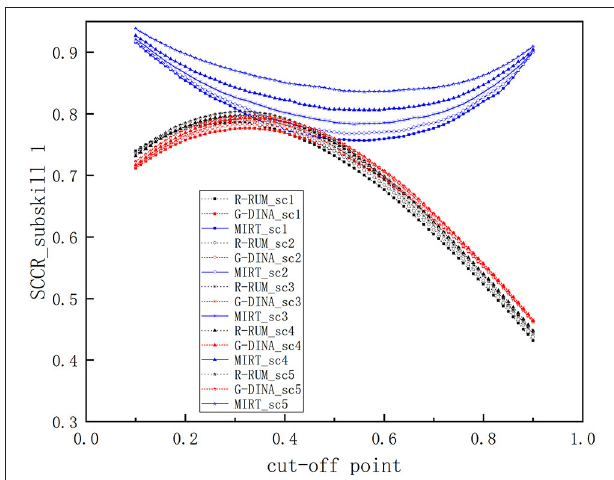
FIGURE 2 | Comparison of SCCR 1 s among R-RUM, G-DINA, and